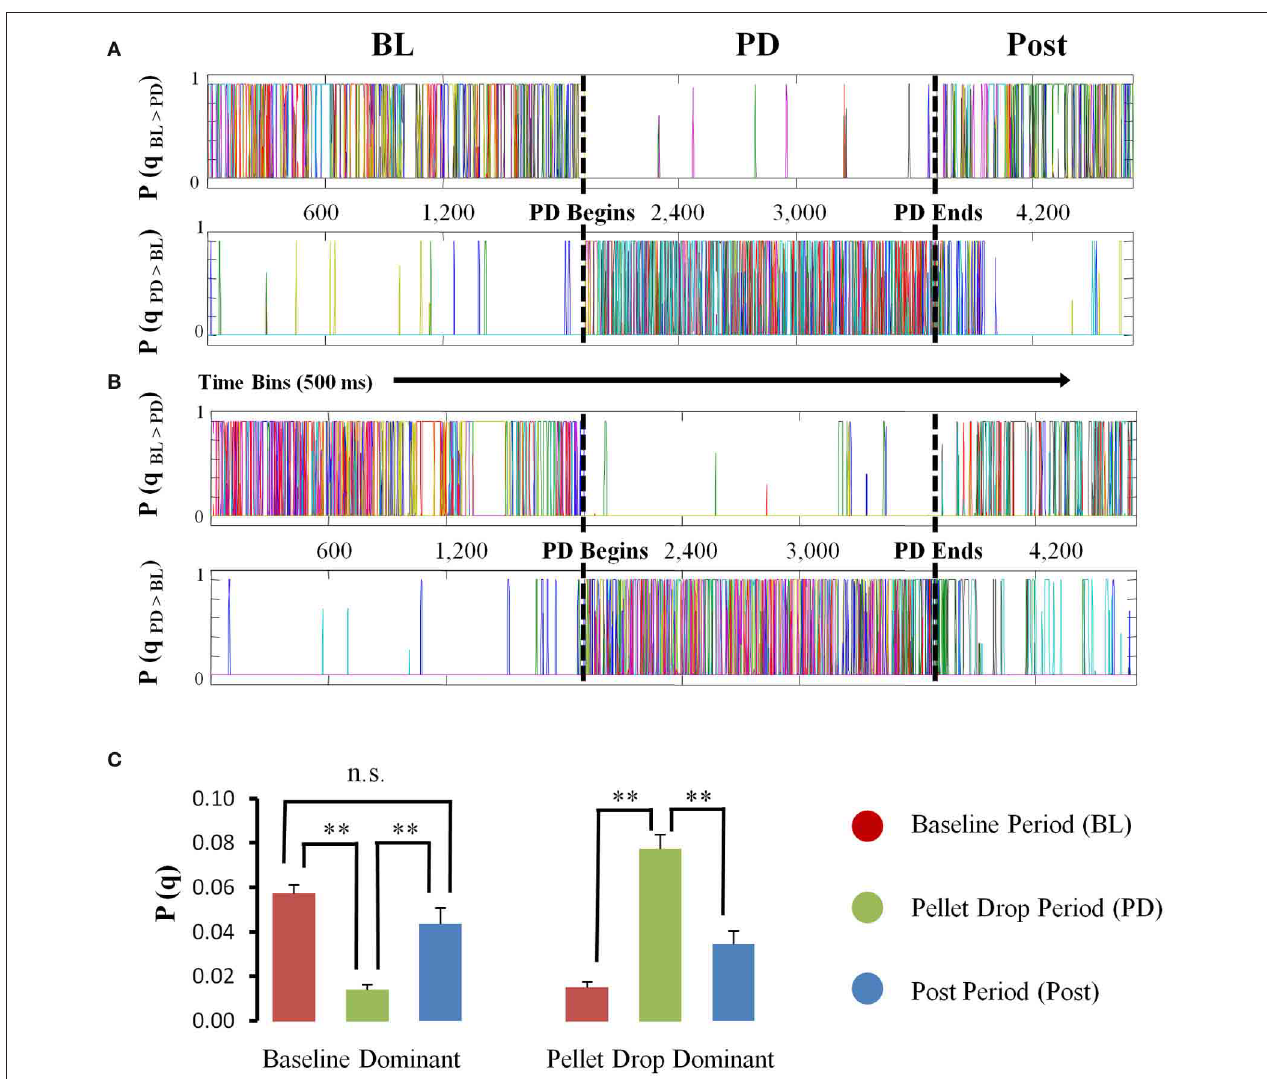
FIGURE 5 | State probabilities present throughoutpellet drop sessions. ( A and B ) Posterior probabilities for two sample sessions. For each session, the states derived from the HMM were divided into one of two groups (“baseline dominant” or “pellet drop period dominant”), based on whether their posterior probabilities were larger (top panel A,B ) for the baseline period (denoted by a BL) versus the pellet drop period (denoted by a PD) or vice